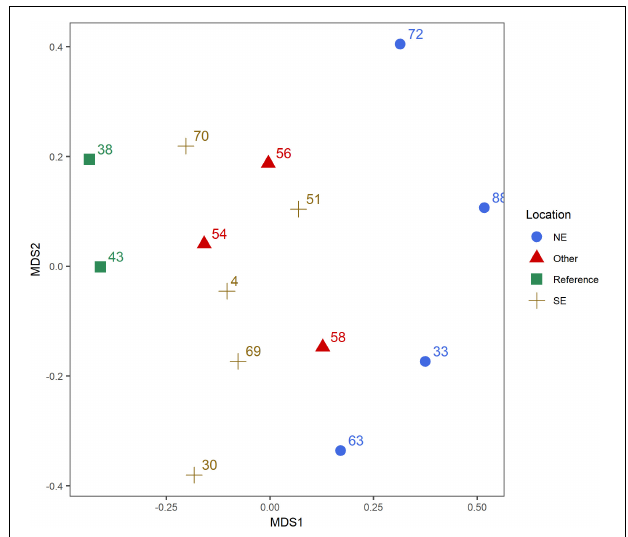
FIGURE 3 | Non-metric multidimensional scaling (nMDS) plot for community composition. The nMDS is based on Bray–Curtis dissimilarities after square root transformation of the relative abundance of reads for all metazoan OTUs.